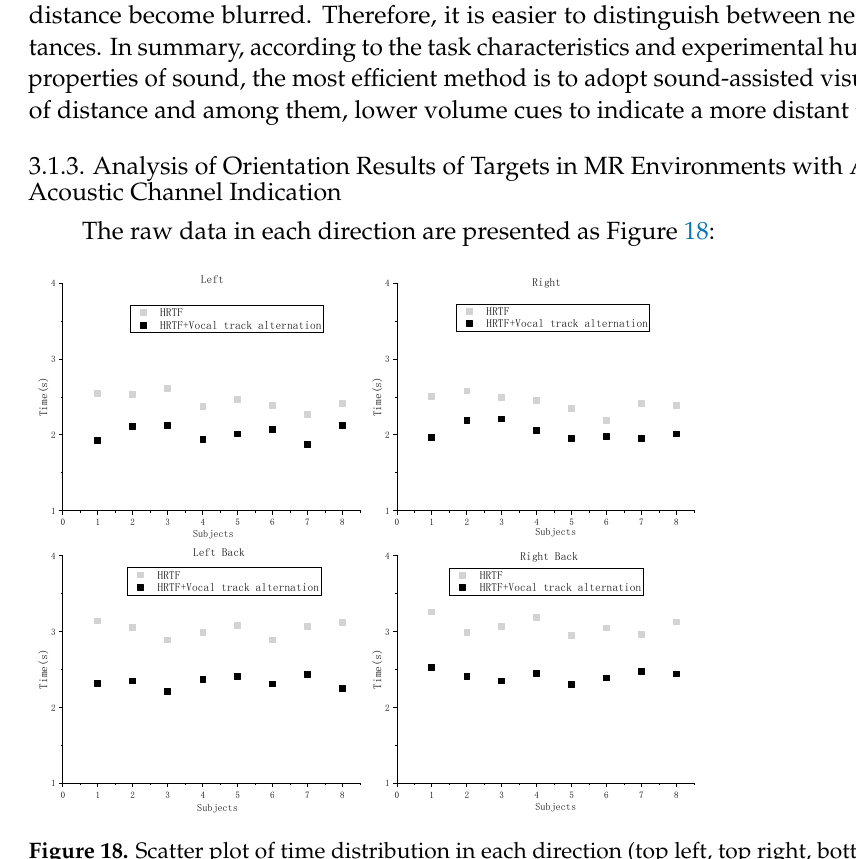
Figure 18. Scatter plot of time distribution in each direction (top left, top right, bottom left, bottom right are left, right, back-left, and back-right directions, respectively).